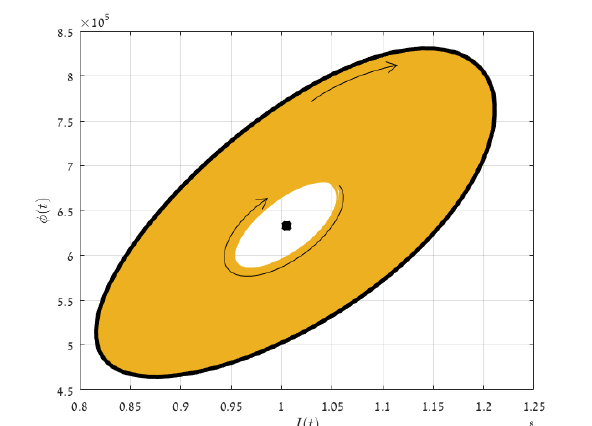
Figure 2: Convergence to a limit cycle in the phase plane spanned by the neutron flux and the iodine number density. The limit cycle, illustrated as a black curve, represents stable oscillatory reactor dynamics. The black dot corresponds to the steady-state solution (from